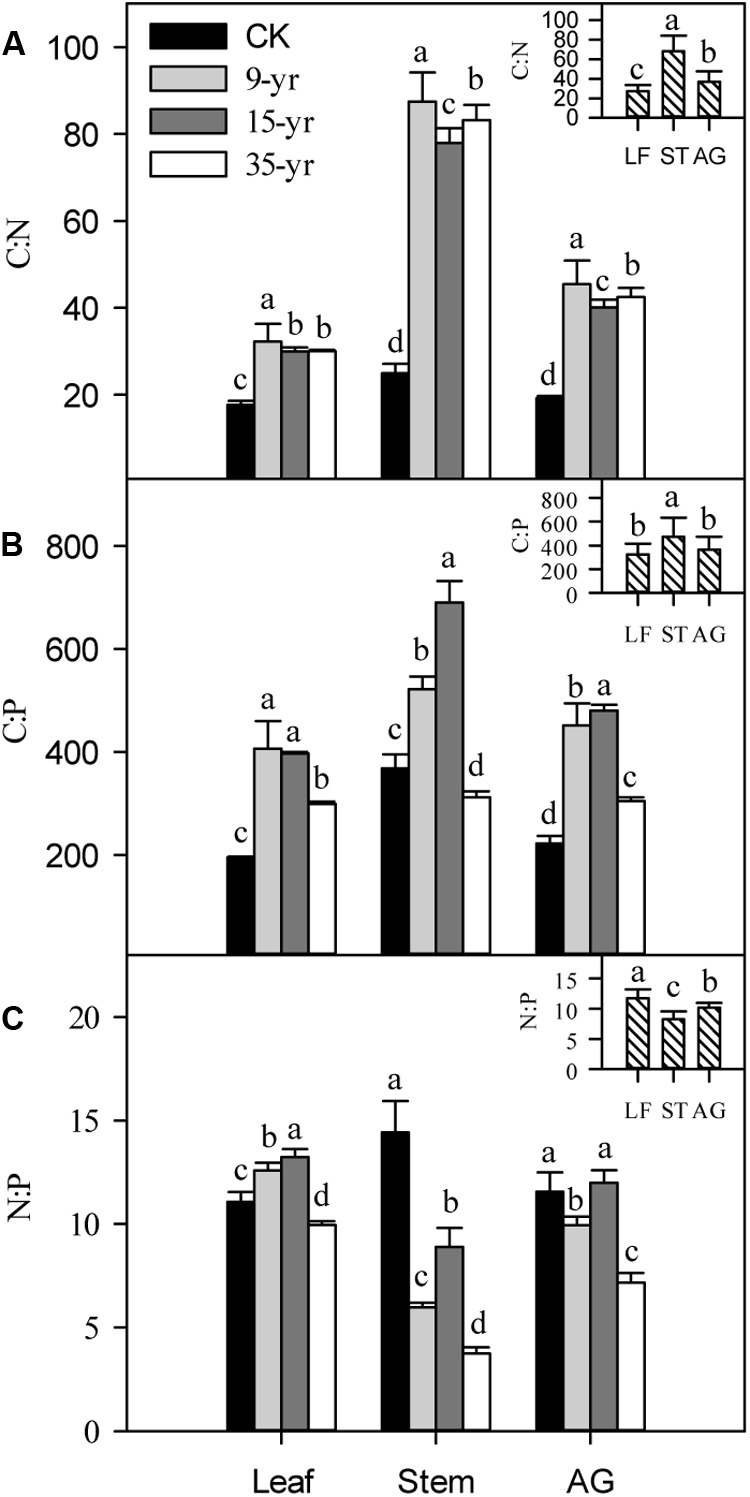
Effects of grazing exclusion on C:N (A), C:P (B), and N:P (C) in leaves (LF), stems (ST), and the aboveground (AG) portions in Leymus chinensis individuals following grazing exclusion (mean ± SD). Different superscripts denote significant differences (P < 0.05).